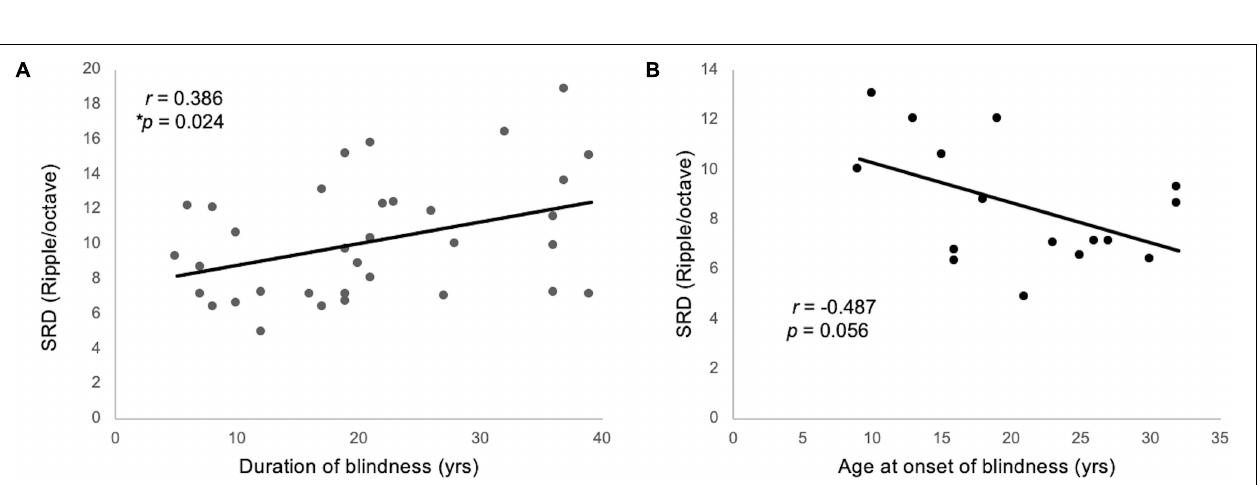
Frontiers in Neuroscience |